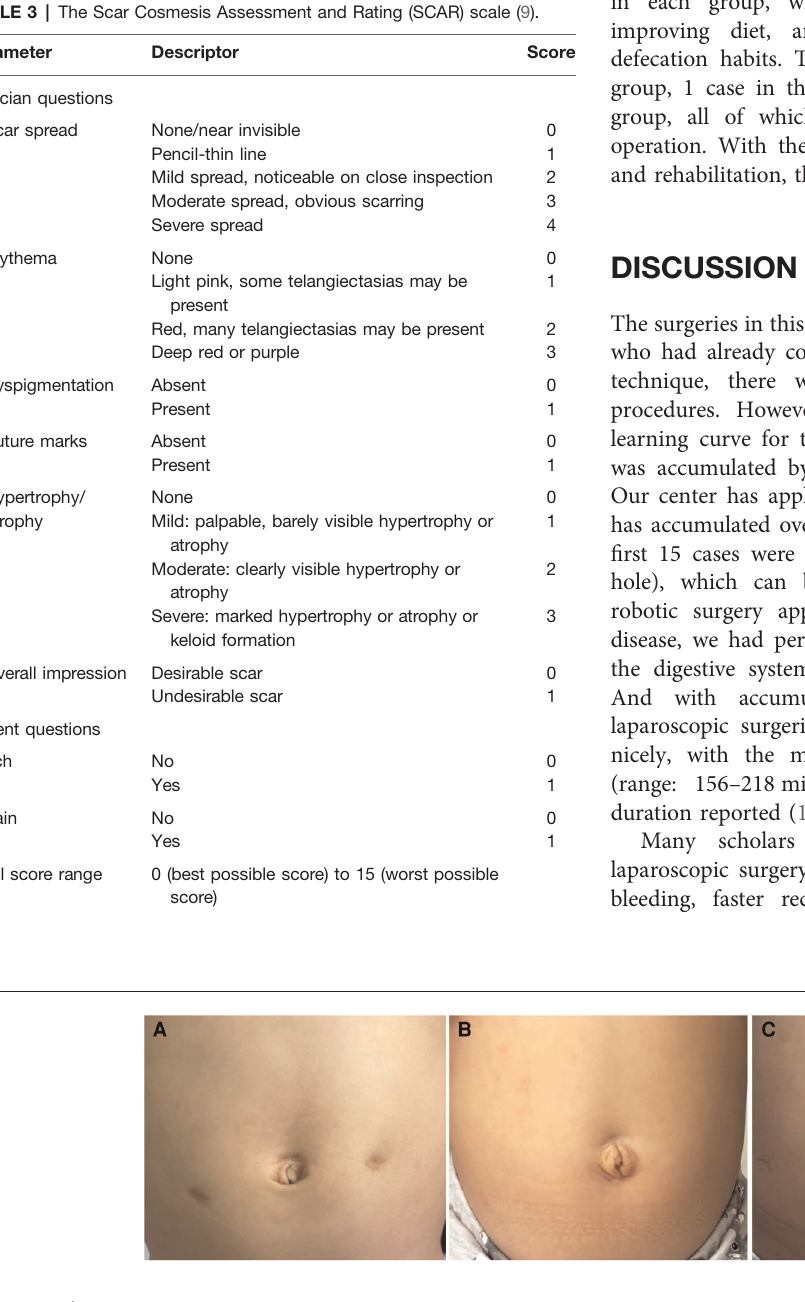
FIGURE 3 | The pictures of the umbilical region of infant undergone CLS ( A ), TUSS-LESS ( B ) and RS ( C ) 6 months after hospital discharge, respectively.